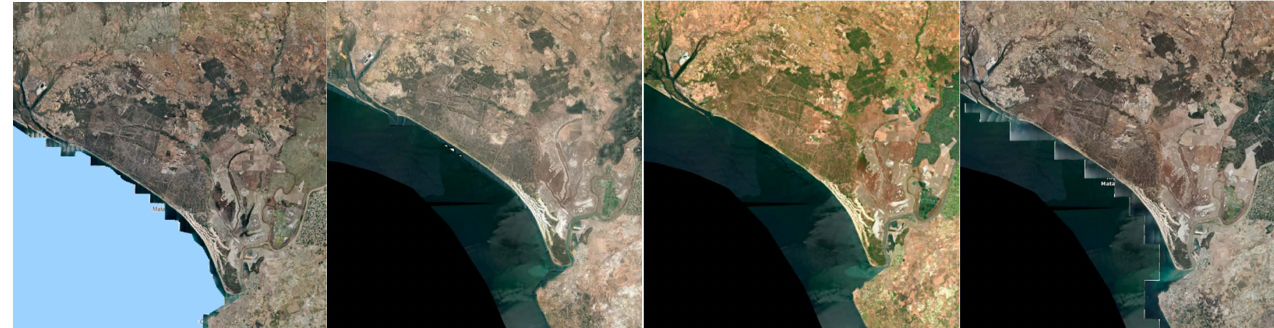
Figure 13. Sequences of satellite images of the area of study of the Doñana National Park for 2005, 2010, 2015 and 2020.